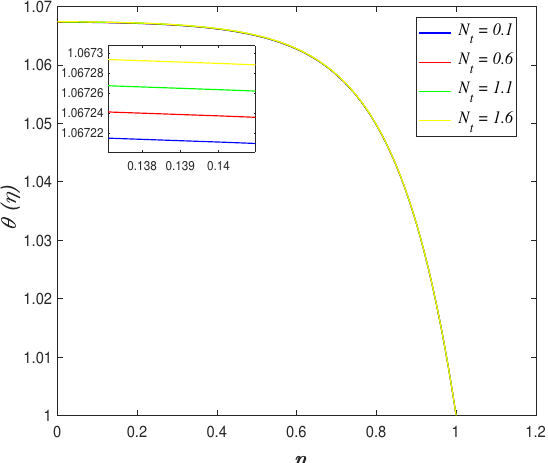
Figure 20. Impact of N t on